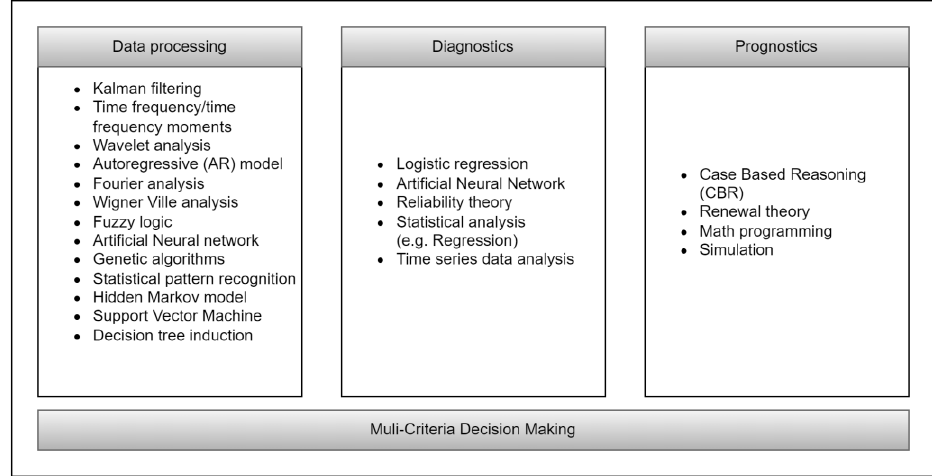
Figure 1. Most common CBM techniques presented in [20].